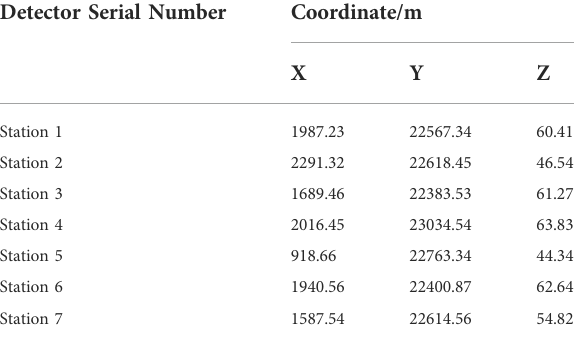
TABLE 8 Three-dimensional coordinates of the geophones at